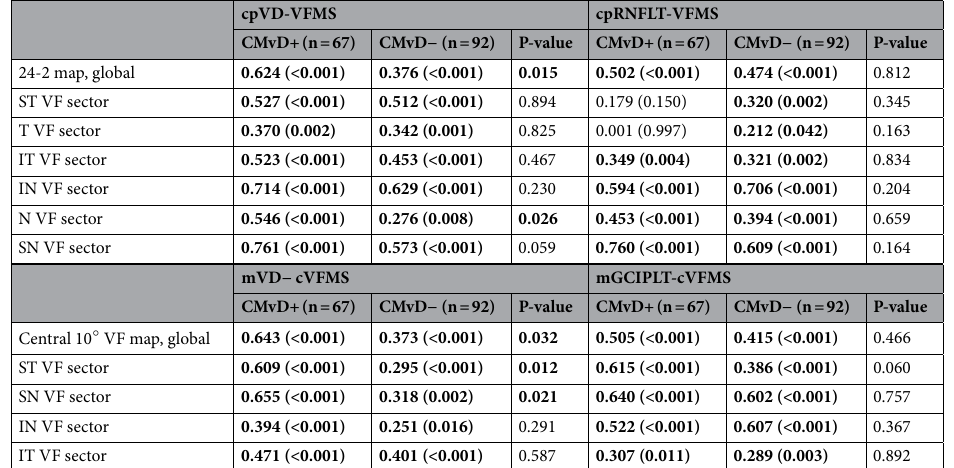
Table 3. Comparison of the vasculature– and structure–function relationships between open-angle glaucoma eyes with and without choroidal microvasculature dropout. CMvD choroidal